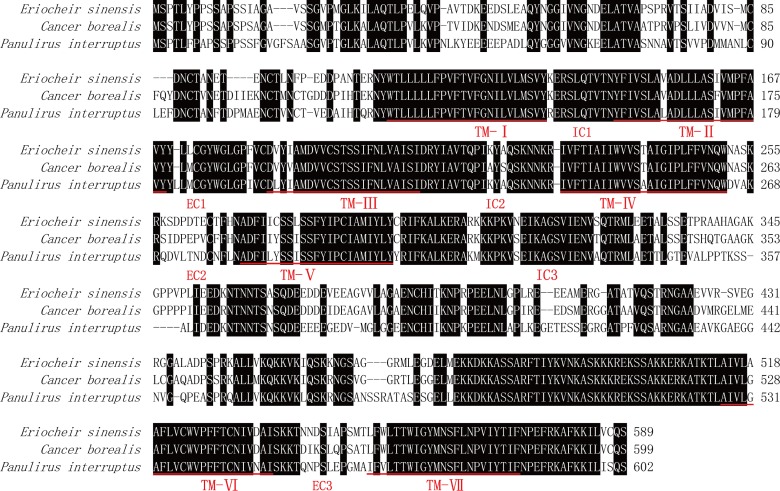
Alignment of amino acid sequences of the DA2 receptor from E. sinensis and other invertebrates.The deduced amino acid sequence of the DA2 receptor from E. sinensis was compared with the DA2 receptor sequences from C. borealis (AOG14374.1) and P. interruptus (ABI64137.1) with the ClustalX program. Conserved of residues are highlighted in black. The seven transmembrane domains (TM-Ⅰ –TM-Ⅶ), three extracellular loops (EC) and three intracellular loops (IC) are marked.